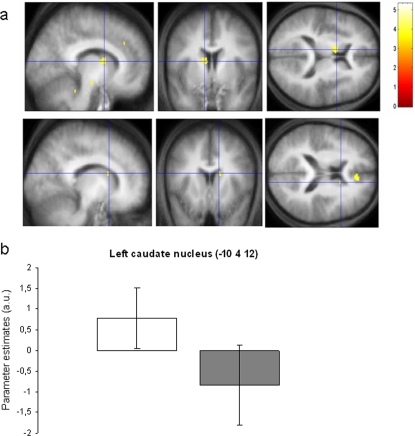
Within-subjects correlation analyses between brain activity and trial to trial performance in the Natural condition.Contrasts are displayed at p<0.001 (uncorrected) superimposed on the average T1-weighted MR scan. a) Higher correlations with performance in the RS than TSD group in the left (−10, 4, 12; Z = 3.72; top panel) and right (14, 14, 18; Z = 3.39; bottom panel) caudate nuclei. b) Parameter estimates (arbitrary units±standard deviations) of correlation between performance and brain activity in the left caudate nucleus (−10 14 12), indicating a positive association in the RS group (white plot), and a negative association in the TSD group (grey plot).